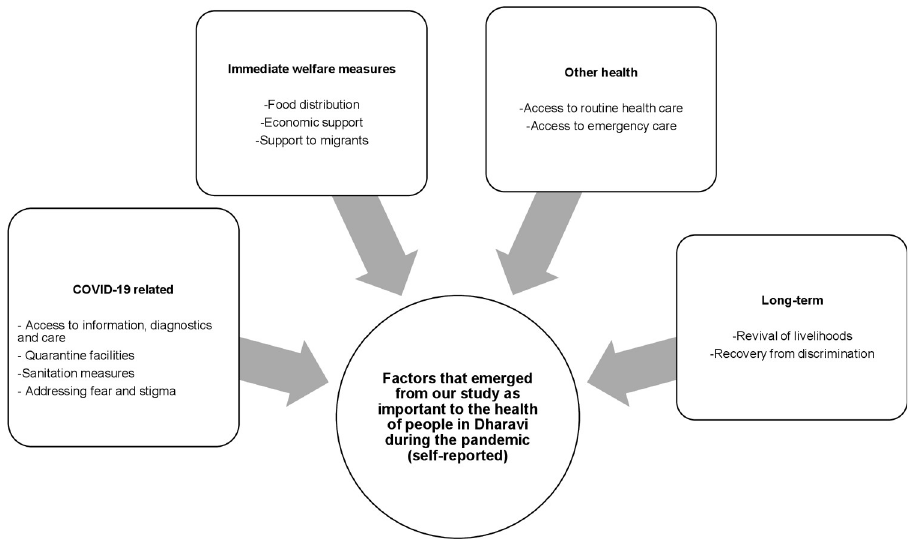
Fig 3. Factors that emerged as influencers of health outcomes in Dharavi from our